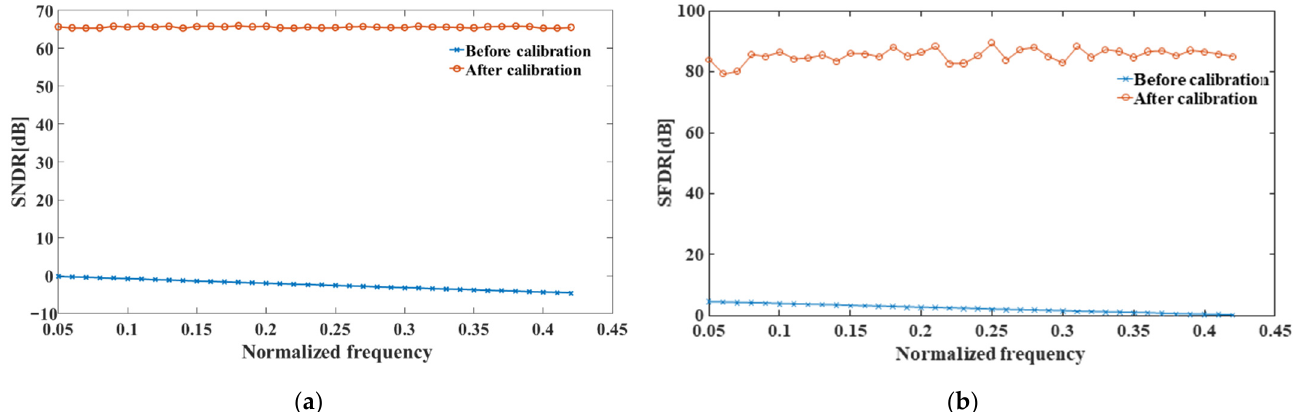
Figure 9. Performances of the proposed method in the third Nyquist bandwidth of the sub-ADC. ( a ) The SNDR of TI-ADCs with different frequencies; ( b ) the SFDR of TI-ADC with different frequencies.